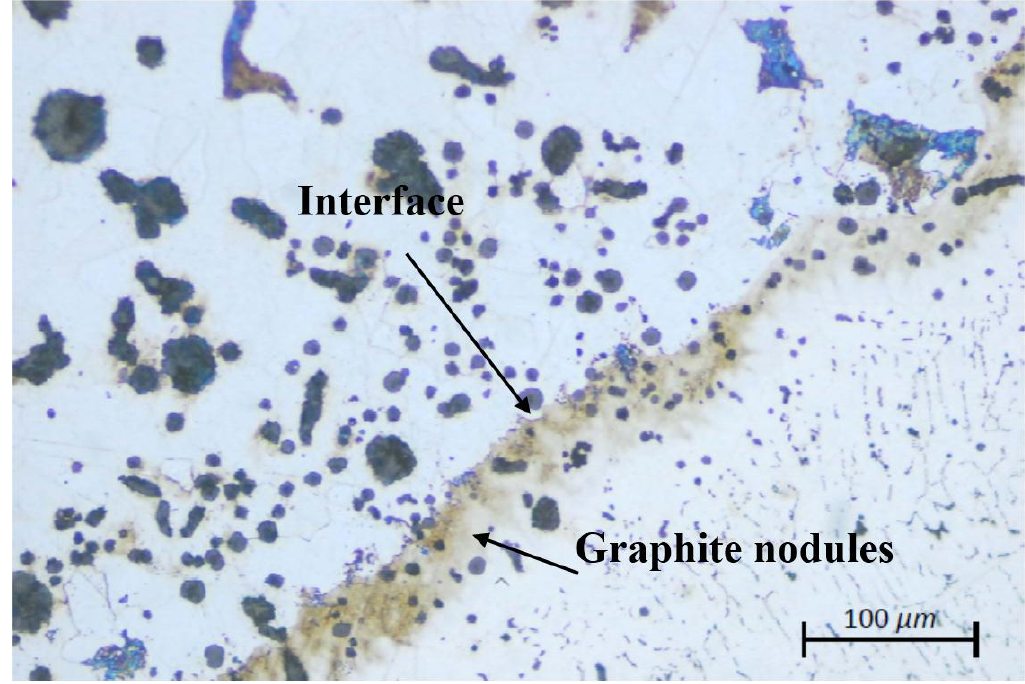
Figure 6. Micrograph of the filler zone in a ductile iron weld using a 97.6% Ni coated electrode with subsequent thermal annealing at 900 °C.